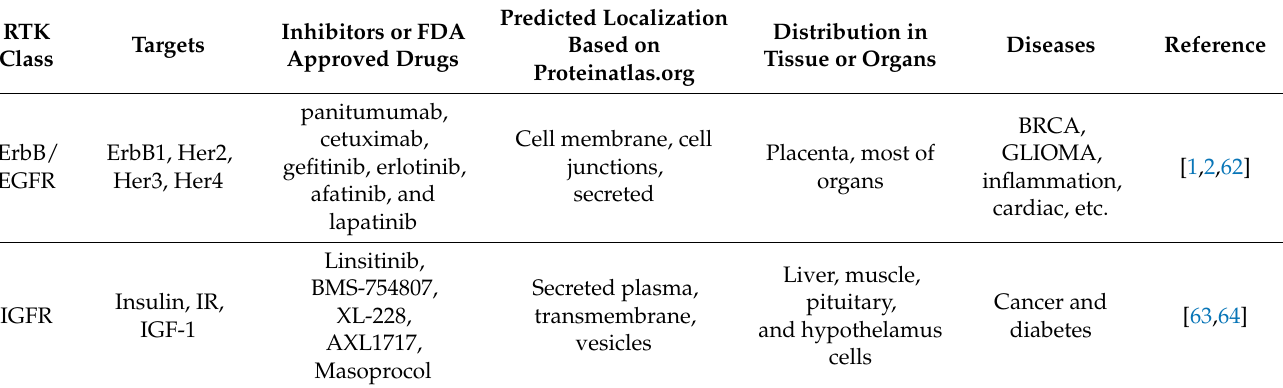
Table 1. Major RTKs in human diseases and their effective inhibitors in clinical